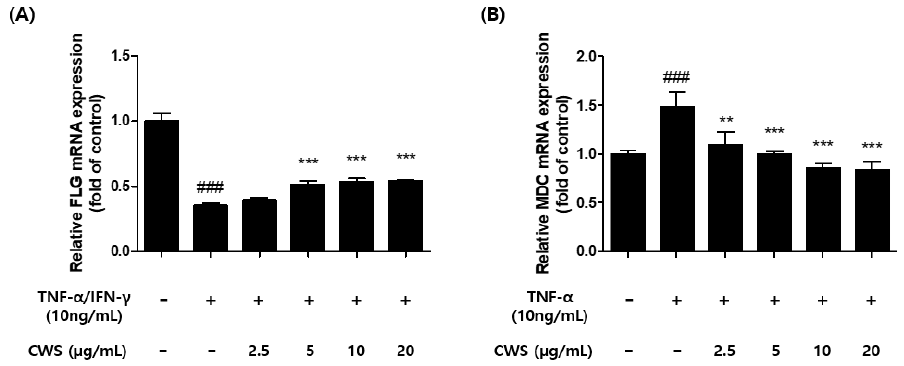
Figure 2. Effects of CWS on mRNA expression of AD-related skin structural protein and chemokine in HaCaT cells. Cells were treated with varying concentrations of CWS and induced with TNF- α and IFN- γ (10 ng/mL each) or TNF- α only (10 ng/mL). The mRNA expression levels of ( A ) FLG and ( B ) MDC were examined by RT-PCR. The data are expressed as the mean ± standard deviation ### p < 0.001 indicates a significant difference between the induced group and untreated control; ** p < 0.01, *** p < 0.001 indicates a significant difference between the sample treatment group and induced group.